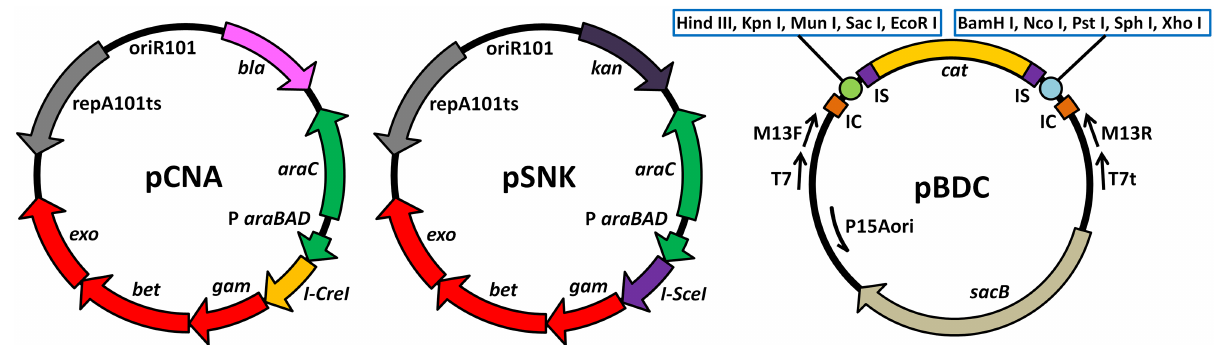
Fig 1. Plasmid maps of pCNA, pSNK, and pBDC. The helperplasmidspCNA and pSNK, which could be eliminatedby incubationat 42˚C, were obtaineduponinsertionof I-CreI and I-SceI , respectively, into pKOBEG. The bla cassette was obtained from pET3b (Novagen), and the kan cassette was obtainedfrom pET28a (Novagen). The p15A ori and cat cassettes of the landingpad plasmidpBDC were obtained from pACYCDuet-1 (commercialplasmidpurchased from EMD Biosciences). IC and IS represent the I-CreI endonuclease recognitionsite and I-SceI endonuclease recognition site, respectively.